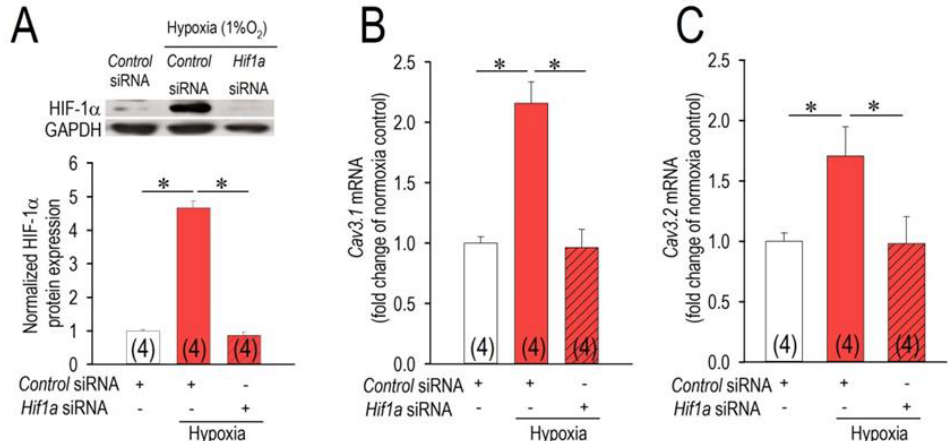
Figure 2. HIF-1  -dependent regulation of the Cav3 channels in hypoxia. ( A ) Changes of HIF-1  Figure 2. HIF-1 α -dependent regulation of the Cav3 channels in hypoxia. ( A ) Changes of HIF-1 α proteins expression in proteins expression in cardiomyocytes exposed to normoxia or hypoxia for 3 h, and actions of cardiomyocytes exposed to normoxia or hypoxia for 3 h, and actions of Hif1a knockdown on them by use of control-siRNA (scramble siRNA, 10 nM) or Hif1a -siRNA (10 nM) transfected with Lipofectamine RNAiMAX for 48 h. After transfection, cardiomyocytes were exposed to hypoxia for 3 h, and then assessed by Western blot analysis. Representative protein images are shown above. Similar results were obtained from three independent experiments (See Figures S1 and S2). Amounts of HIF-1 α proteins were normalized to those with control-siRNA in normoxia as assigned as 1.0. ( B , C ) Suppression of Cav3.1 - and Cav3.2 -mRNA by Hif1a -siRNA (10 nM). Experimental protocols were identical to those in panel ( A ). * p < 0.05, compared with those in the normoxic control group with control-siRNA or hypoxic group with Hif1a -siRNA as indicated. Numbers of experiments are given in parentheses (n =